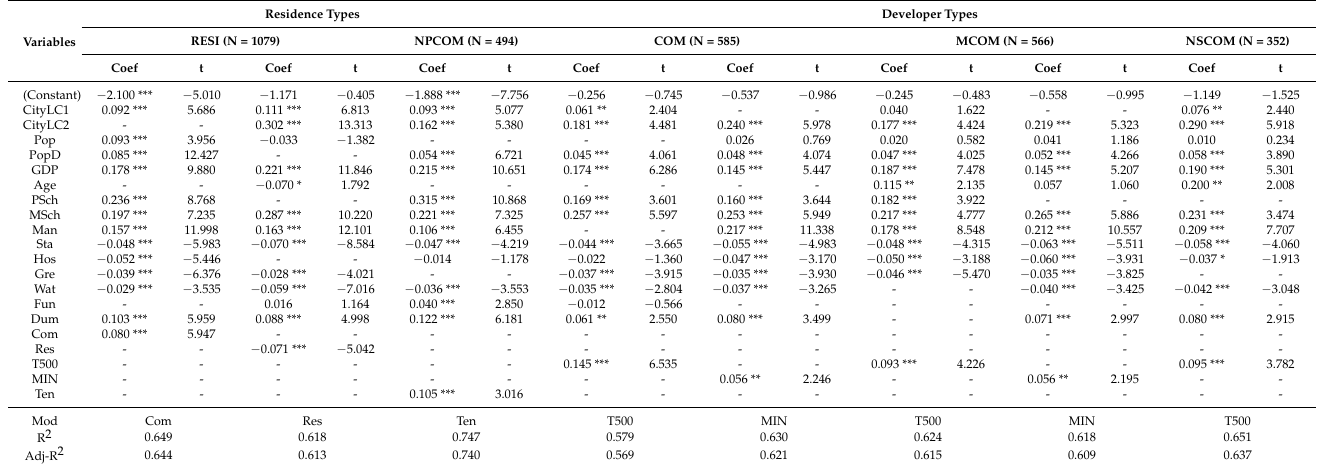
Table 9. Robust test results of linear